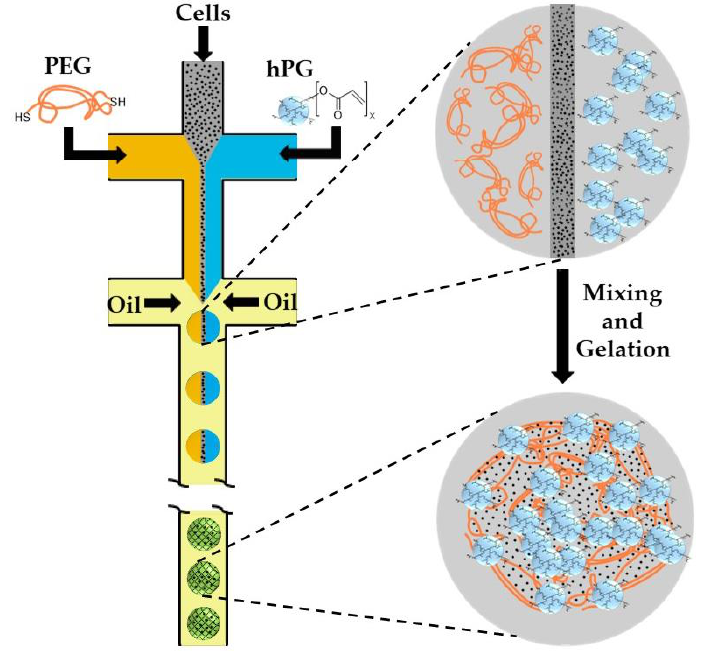
Figure 20. Formation of cell-laden polyethyleneglycol (PEG)-hyperbranched polyglycerol (hPG) microgel particles by thiol-ene “click” reaction. The gelation is achieved by nucleophilic Michael addition of PEG-dithiol to acrylated hPG building blocks without any initiator or UV light [78,80]. Thiol-terminated PEG (PEG-dithiol) can be synthesized by the reaction between PEG-diamine and 2-iminothiolane at room temperature, as shown in Figure 21. The chemical structure of microgel particles after crosslinking is shown in the same figure.